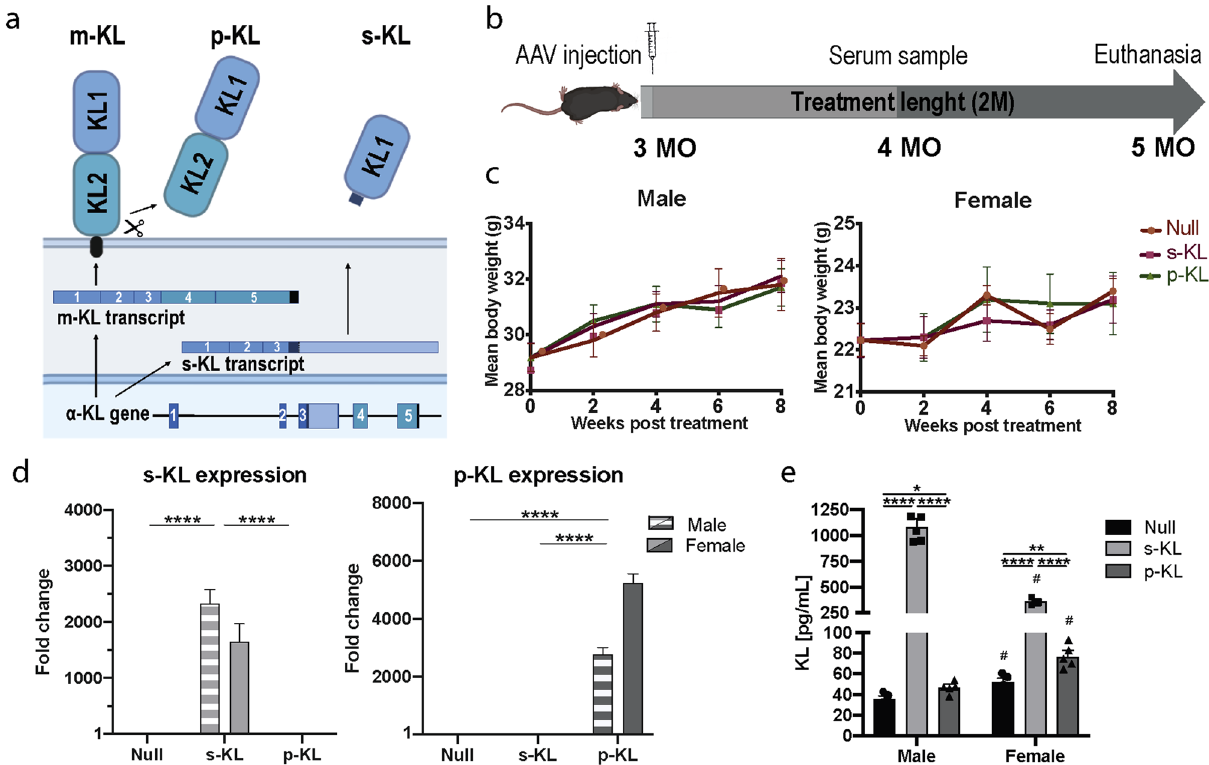
Figure 1. ( a ) Scheme with the different KL isoforms. ( b ) Experimental design followed. ( c ) Body weight follow up displayed as increase in grams during the 8 weeks-long treatment. No differences in body weight were observed between groups before the start of the experiment (t = 0) or after 8 weeks. ( d ) Gene expression of secreted and processed KL in liver 2 months after the treatment. Stripped bars represent gene expression in males and solid bars in females. Data presented as fold change expression compared to Null treated animals. ( e ) KL protein levels in serum 2 months after the treatment. Mean ± Standard error of the mean (SEM) for ( c,e ), and relative quantity (RQ) ± standard error of RQ for ( d ); n = 4–6; # p < 0.05 for differences between males and females, *p < 0.05; **p < 0.01; ***p < 0.001; ****p < 0.001 for differences between different treatment groups within the same